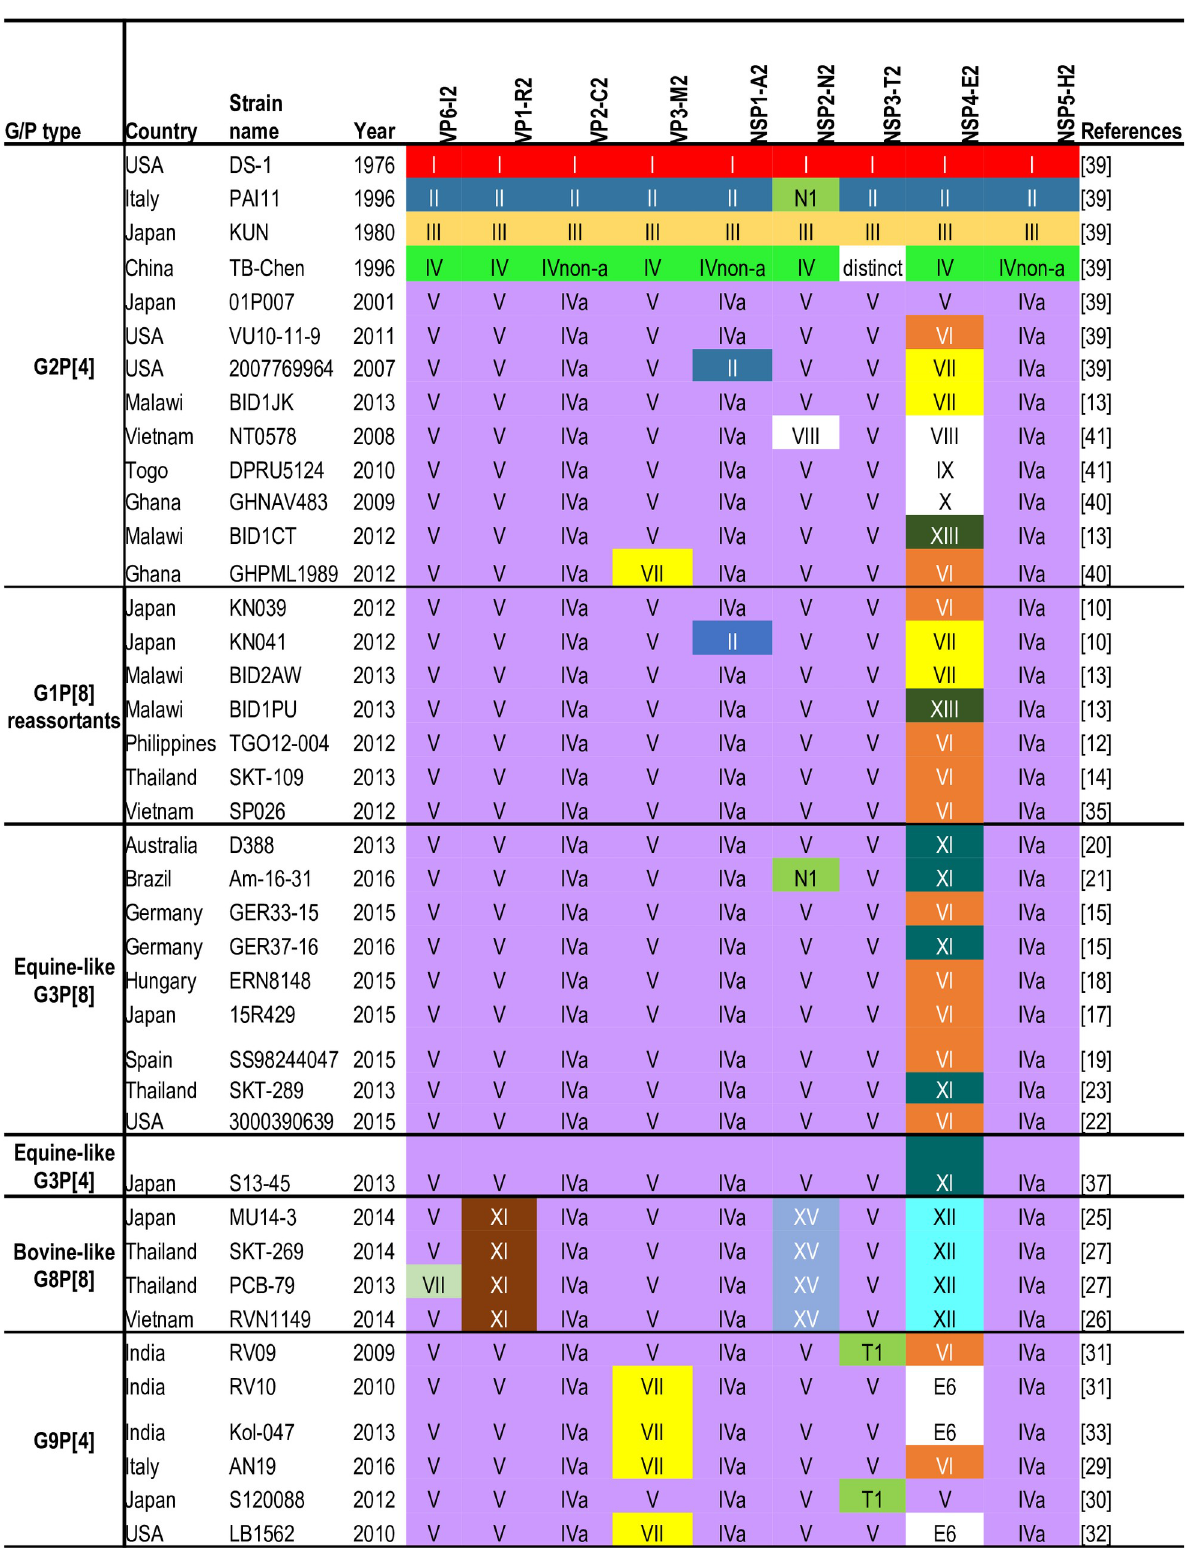
Fig 1. Lineage constellation of representative G2P[4] and representative genotype 2 reassortant strains. Lineage colours for I-V, VII and VII (for VP3 and NSP4) were adapted from Doan et al.’s [39] G2P[4] lineage designation. https://doi.org/10.1371/journal.pone.0217422.g001 PLOS ONE | https://doi.org/10.1371/journal.pone.0217422 May 31,